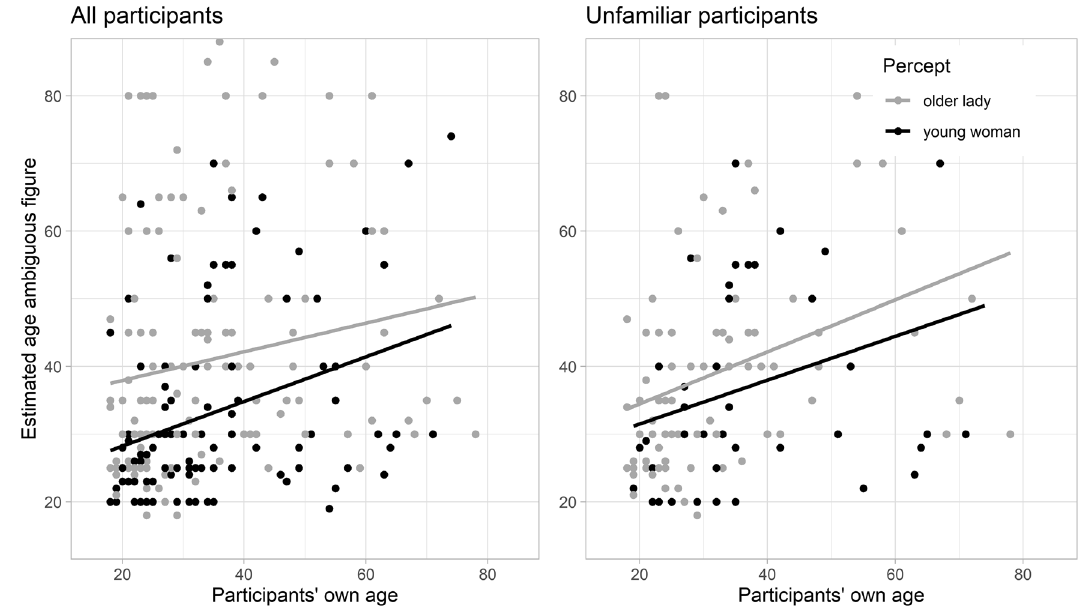
Figure 3. Relationship between participants’ own age and the estimated age of the ambiguous ‘my wife/mother- in-law’ figure as a function of the two percepts (young woman = black; older lady = gray). The left panel depicts the data from all participants ( N = 246). The right panel only depicts the data from participants who reported not having seen the ambiguous ‘my wife/mother-in-law’ figure prior to the study ( n =